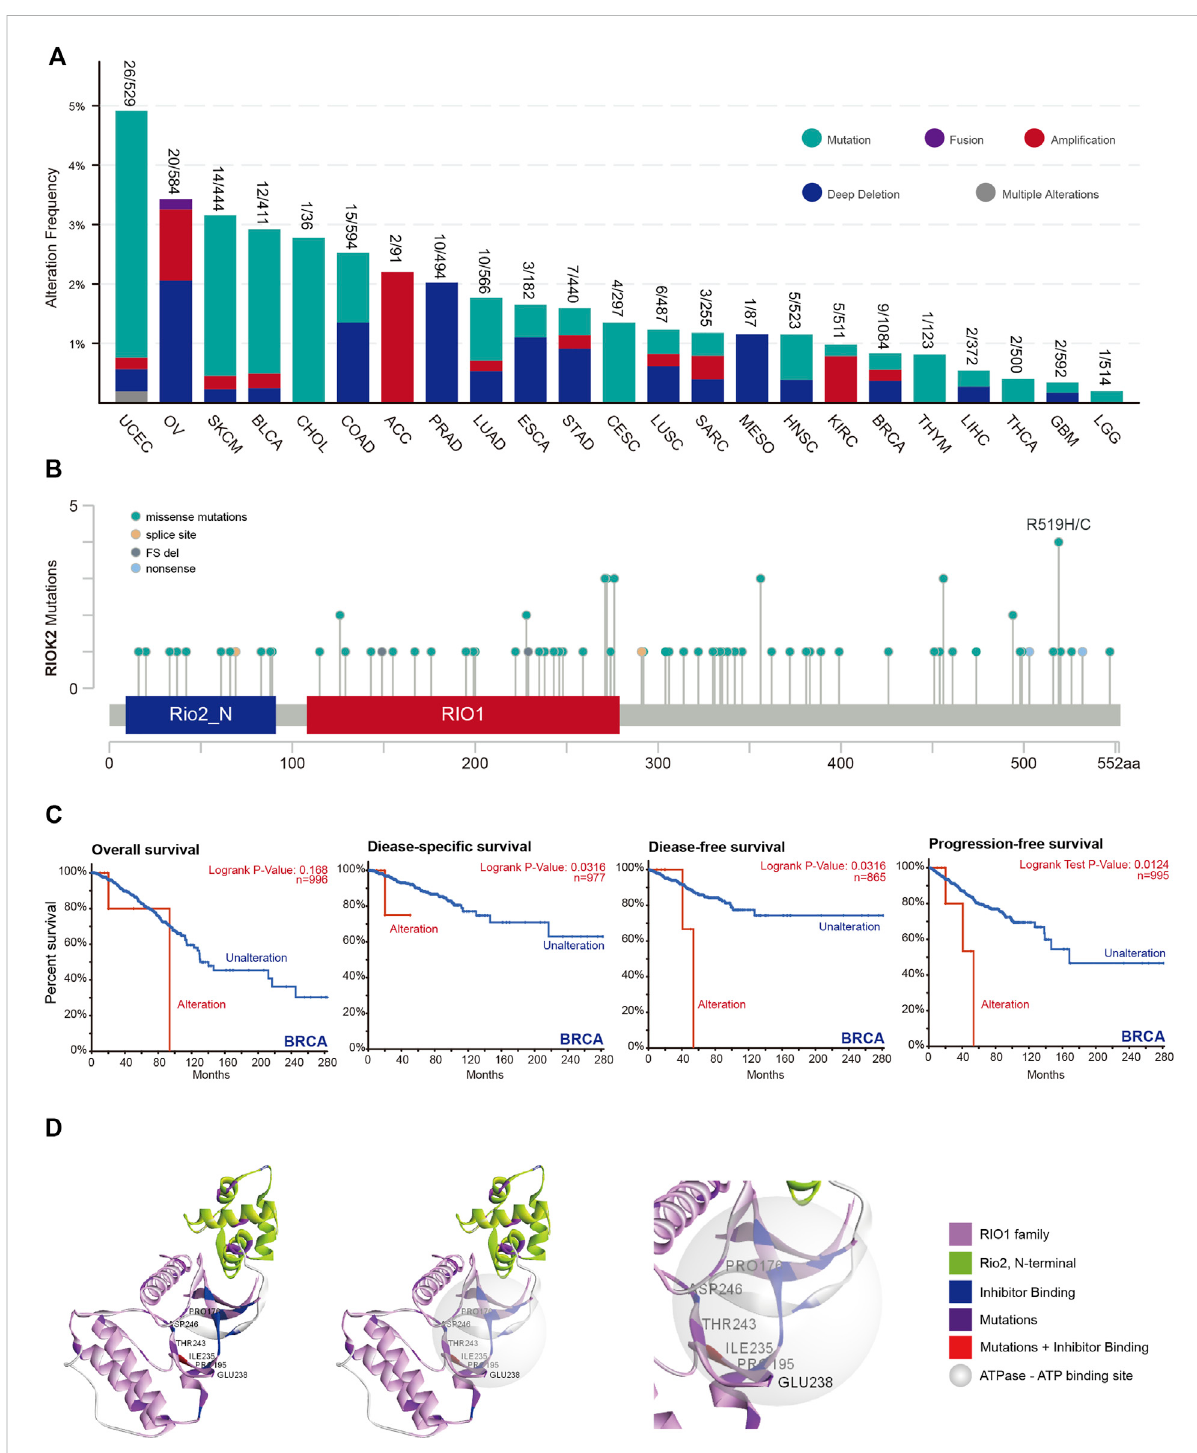
Mutation feature of RIOK2 in different tumors of TCGA. (A) The histogram compares the frequency of RIOK2 gene alteration type between different tumors. (B) Mutation sites of RIOK2 in 32 studies of TCGA Pan-Cancer Atlas. Mutation diagram circles are colored with respect to the corresponding mutation types. In case of different mutation types at a single position, color of the circle is determined with respect to the most frequent mutation type. (C) The disease-speci fi c,disease-free,and progression-free survival curves of theBRCAwhichhave signi fi cant survival risk( p < 0.05). (D) TheimageindicatestherelationshipbetweenthedomainoftheRIO1family,N-terminalofRIO2,ATP-bindingsite,inhibitorbinding site, and mutation site, using a 3D structure from different